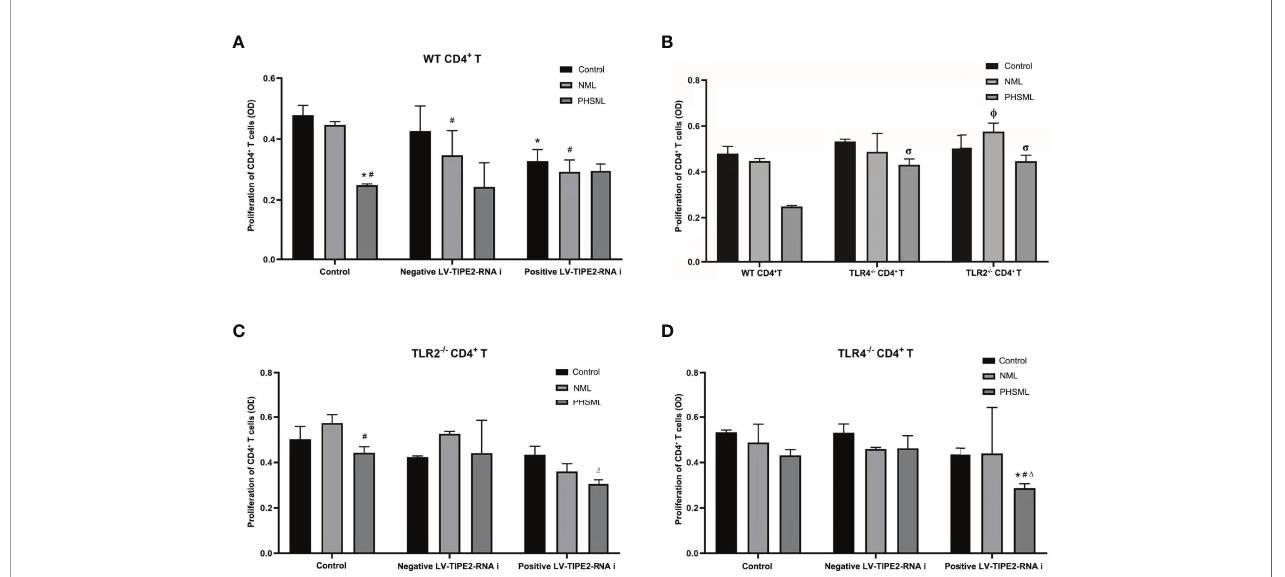
FIGURE 2 | Role of TLR2/TLR4 Mediated TIPE2 in the proliferation of WT CD4 + T lymphocytes reduced by PHSML. (A) The effect of TIPE2 expression on the proliferation of CD4 + T cells induced by PHSML in vitro . (B) The effect of TLR2/TLR4 expression on the proliferation of CD4 + T cells induced by PHSML in vitro . (C) The effect of TIPE2 and TLR2 expression on the proliferation of CD4+T cells induced by PHSML in vitro . (D) The effect of TIPE2 and TLR4 expression on the proliferation of CD4 + T cells induced by PHSML in vitro . Data expressed as the mean ± SE (n = 6). *P < 0.05 vs control treated control group, #P < 0.05 vs NML treated control group, D P < 0.05 vs PHSML treated control group, j P < 0.05 vs NML treated WT CD4 + T group, s P < 0.05 vs PHSML treated WT CD4 + T